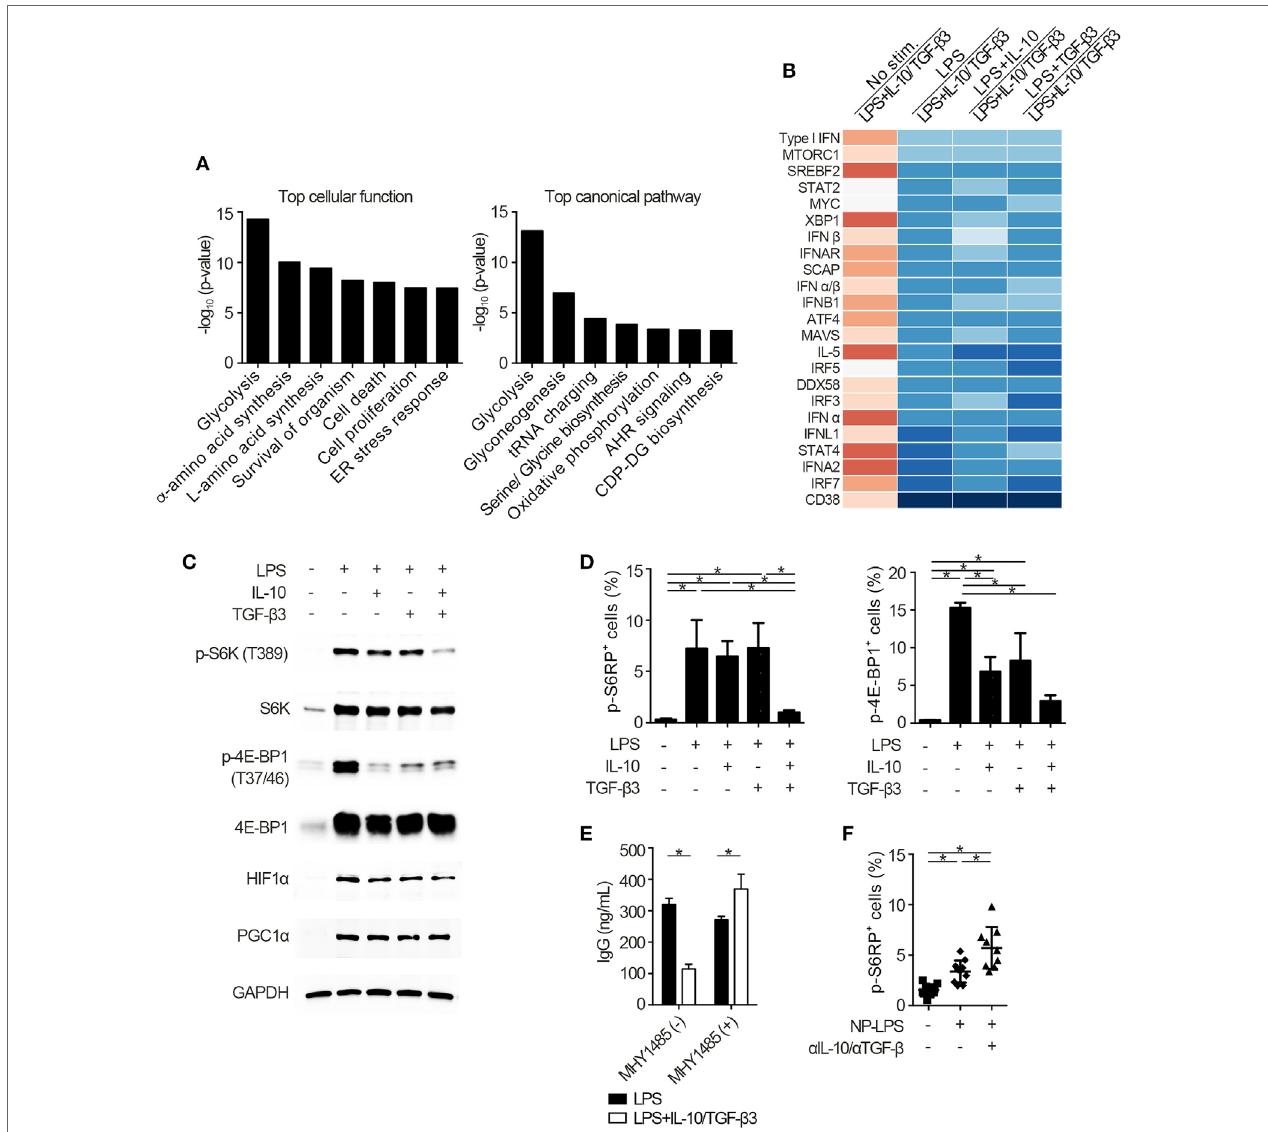
FigUre 5 | Cytokine synergy of TGF- β 3 and interleukin-10 (IL-10) inhibits mammalian target of rapamycin complex 1 (mTORC1) activity in lipopolysaccharide (LPS)-stimulated B cells. (a) The seven most related cellular functions and canonical pathways in genes of cluster 6 in Figure 4a were analyzed by in Ingenuity Pathway Analysis (IPA) software. (B) Heatmap visualization of activation z -score ratios of LPS-stimulated B cells to LPS-stimulated B cells with IL-10/TGF- β 3 less than − 3.1 calculated by the upstream regulator analysis in IPA software. All of the 1,895 differentially expressed genes depicted in Figure 4a were utilized in this analysis. (c) Representative western blot analyses of total and phosphorylated protein levels in LPS-stimulated B cells treated either with TGF- β 3 and/or IL-10 for 24–48 h. (D) Flow cytometric (FCM) quantification of phosphorylated S6RP at Ser235/236 and 4E-BP1 at Thr37/46 in LPS-stimulated B cells either with or without TGF- β 3 and/or IL-10 for 72 h ( n = 3). (e) Total IgG antibody titers in the supernatants of LPS-stimulated B cells with or without TGF- β 3 and IL-10 in the presence or absence of 2 µM MHY1485 for 7 days quantified by ELISA ( n = 3). Data are representative of more than two independent experiments in (c–e) . (F) FCM quantification of phosphorylated S6RP at Ser235/236 in splenic B220 + cells from B6 mice treated as in Figure 2e ( n = 9–10). P < 0.05 by one-way (D,F) or two-way (e) analysis of variance followed by Bonferroni’s multiple comparisons test. Error bars,